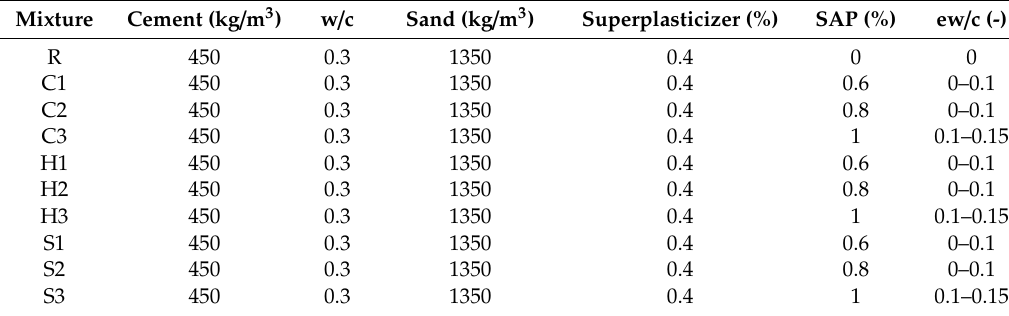
Table 1. Initial mixture